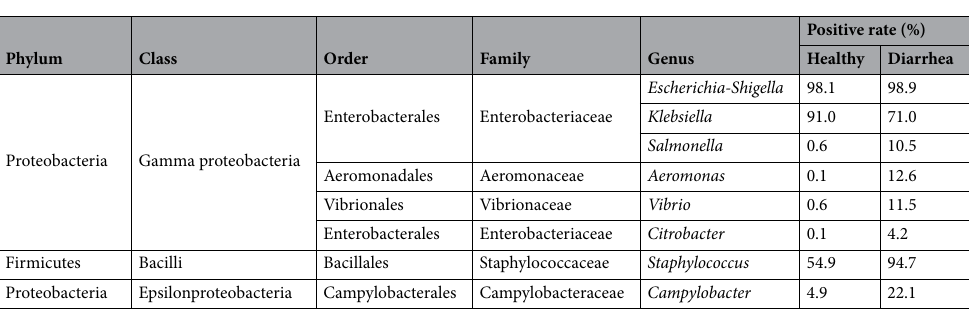
Table 2. Positive rate of fecal microbiome which is causative pathogen